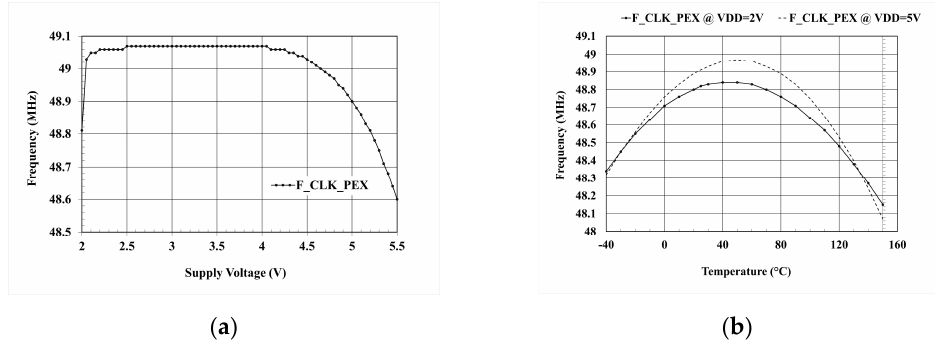
Figure 11. Frequency characteristics with PEX simulations. ( a ) vs. supply voltage; ( b ) vs. temperature.